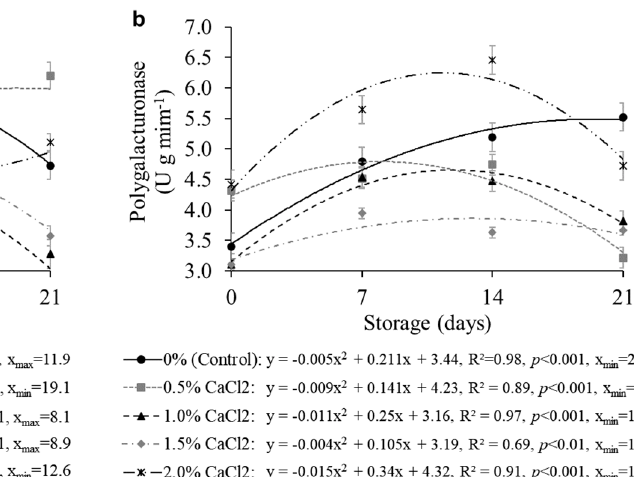
Figure 4. Pectin methylesterase ( a ) and polygalacturonase ( b ) activities of ‘Roxo de Valinhos’ fig fruits as a function of CaCl 2 concentrations and storage days at 5 ± 1 °C and 90–95% R.H. Bars symbolise standard errors (n = 4).